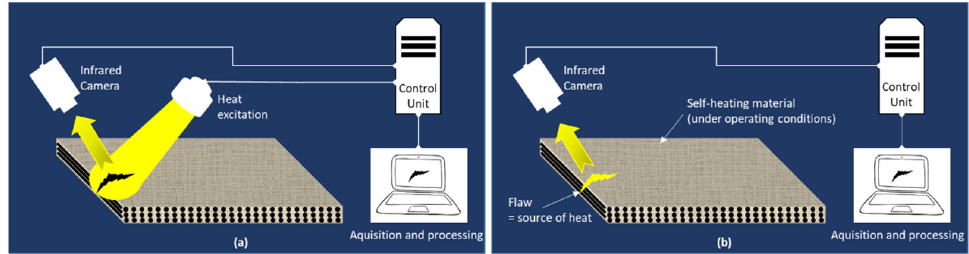
Figure 3. Principle of active ( a ) and passive ( b ) infrared thermography.